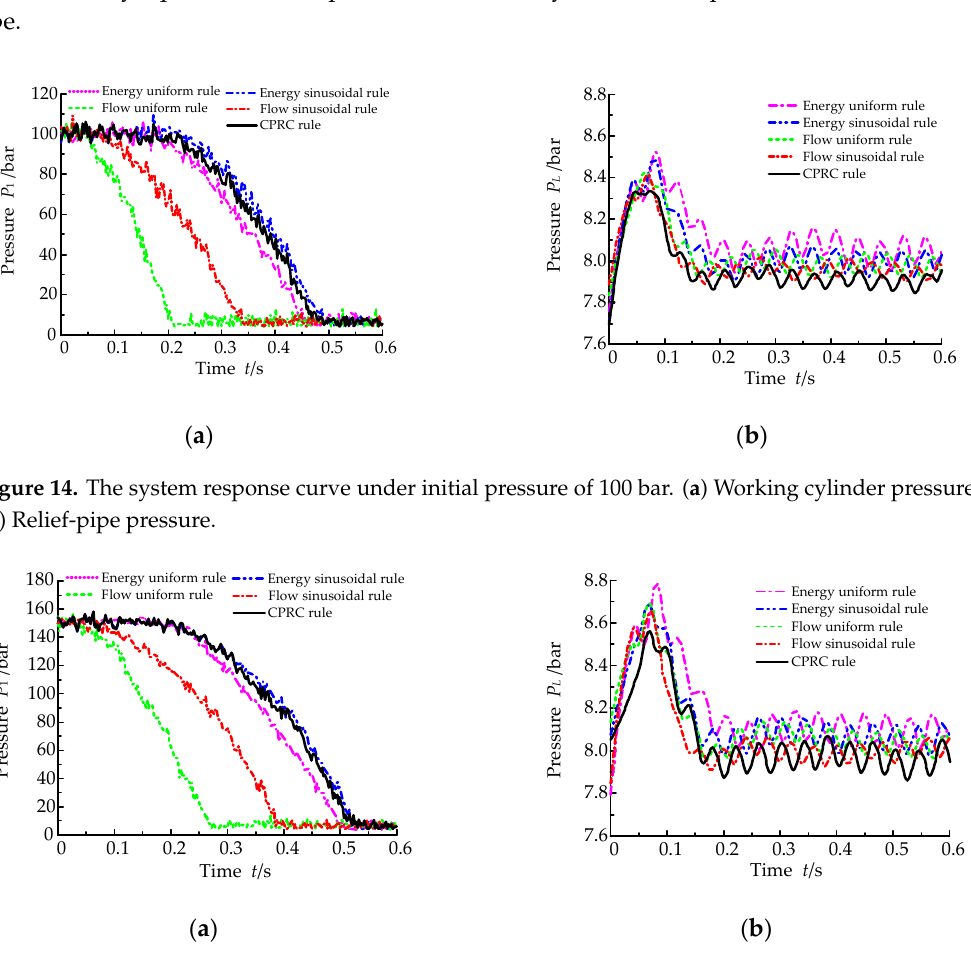
Figure 13. The experiment curves under the step pressure-relief rule. ( a ) Eccentric magnitude; ( b ) Working cylinder pressure; ( c ) Relief-pipe pressure.